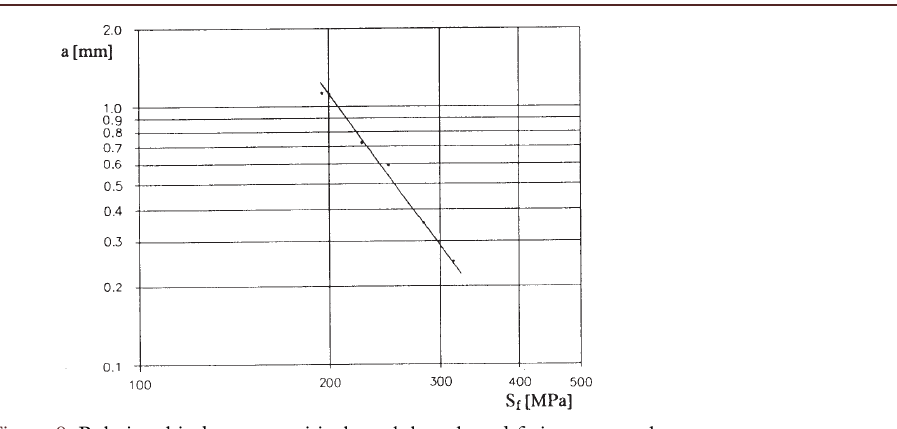
Figure 9: Relationship between critical crack length and fatigue strength.